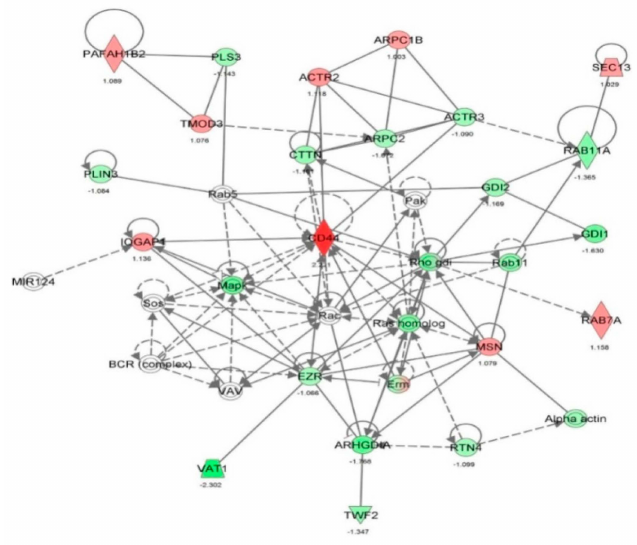
Figure 15. Vancomycin regulated cellular assembly and organization, cellular function and maintenance, and cell morphology. Red indicates an up-regulation; green indicates a down-regulation. The intensity of green and red colors indicates the degree of down- or up-regulation. Solid arrow indicates direct interaction and dashed arrow indicates indirect